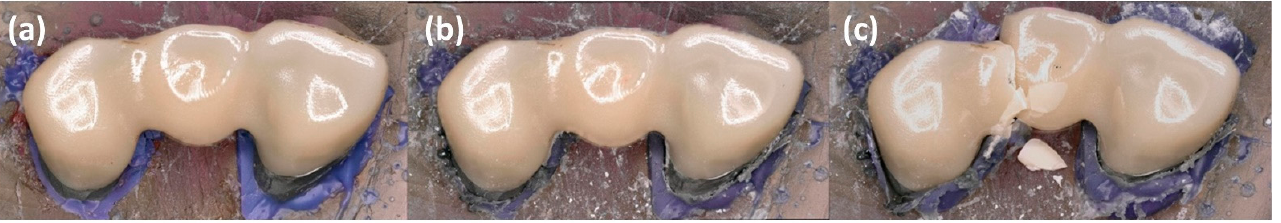
Figure 4. Representative specimen after ( a ) manufacturing, ( b ) aging and ( c ) fracture load test.